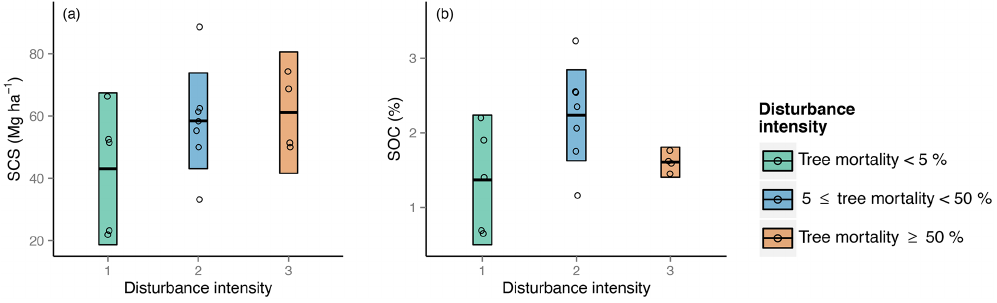
Figure 4. (a) Soil carbon stock (SCS) and (b) soil organic carbon (SOC) (mean ± 95% confidence interval) at 0–30cm depth profile over disturbance intensity classes defined as tree mortality intensity (%).